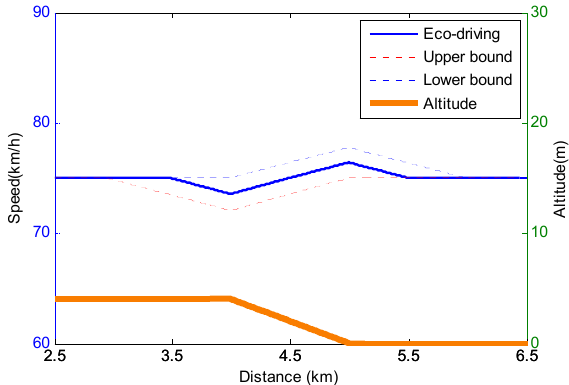
Figure 16. Diagram of the average speed equivalent algorithm for a steep downhill slope.